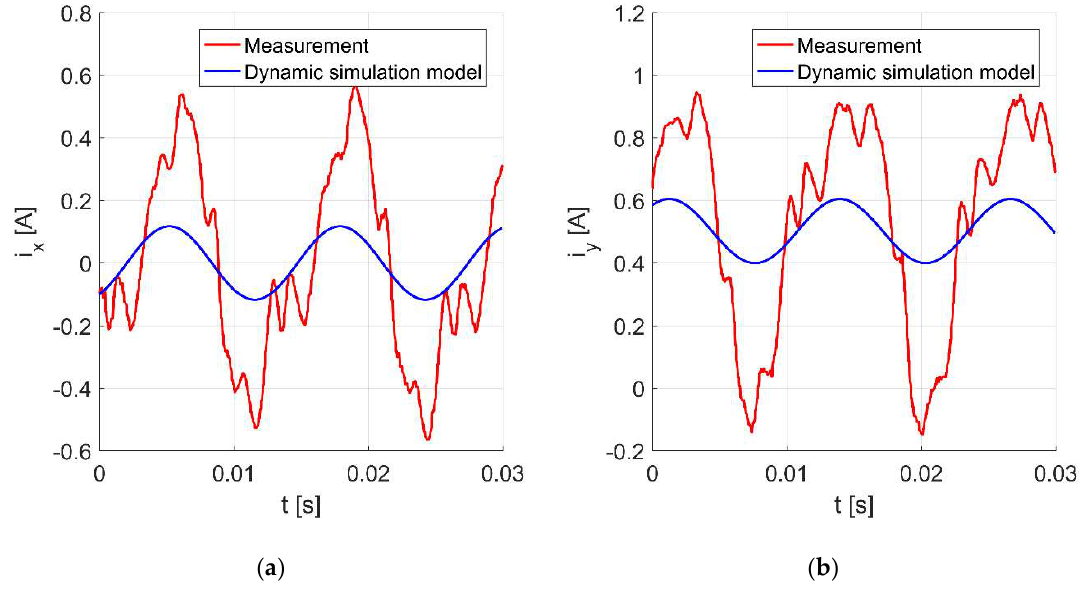
Figure 9. Time responses of the control currents i x ( a ) and i y ( b ) for the rotor rotation with 4724 rev/min.